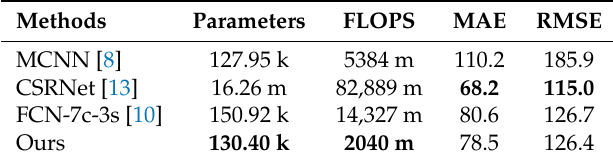
Table 3. Comparison of the networks on the ShanghaiTech Part A